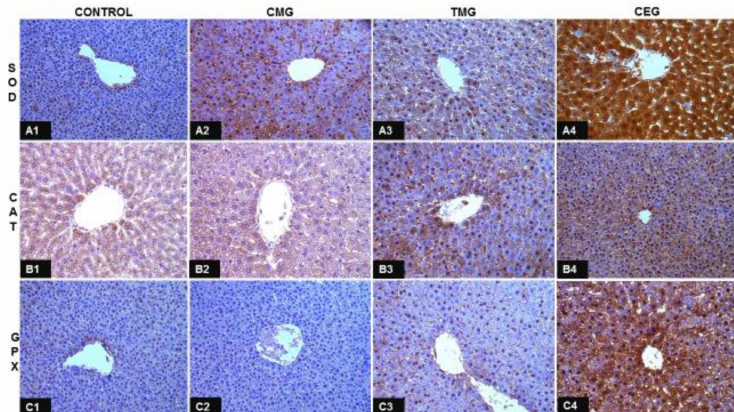
Figure 1. Representative images of livers from control rats (A1-C1) and rats from treatment groups (CMG: A2-C2; TMG: A3-C3; CEG: A4-C4) immunohistochemically stained to show immunoexpression of SOD1 (A2-A4), CAT (B2-B4) and GPX1 (C2-C4) in hepatocytes. Objective magnification 40 ×